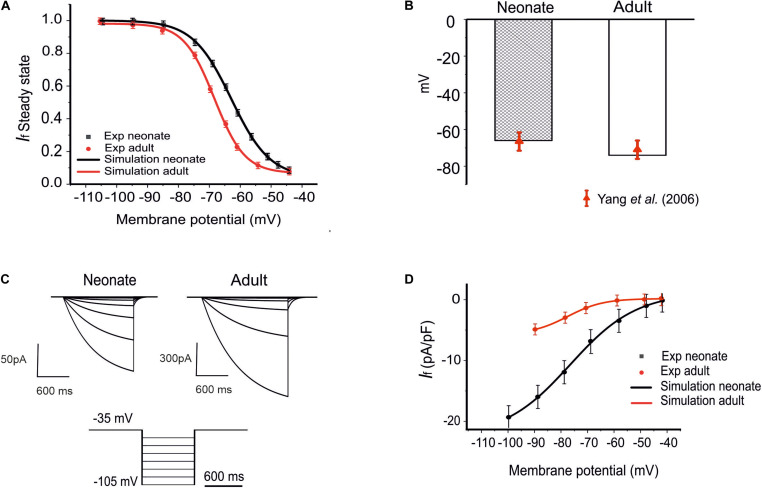
Model of If and its comparison to experimental data. (A) The steady-state activation curves for the If for two age groups: neonates (black line) and adults (red line). (B) Shift of the midpoint of the activation relation. (C) Simulated time traces of If in both neonate and adult SAN cells under the voltage-clamp protocols as shown at the bottom. (D) Simulated I–V relationship. Results are validated against experimental data reported by Honjo et al. (1996); Yang et al. (2006), and Protas et al. (2010).